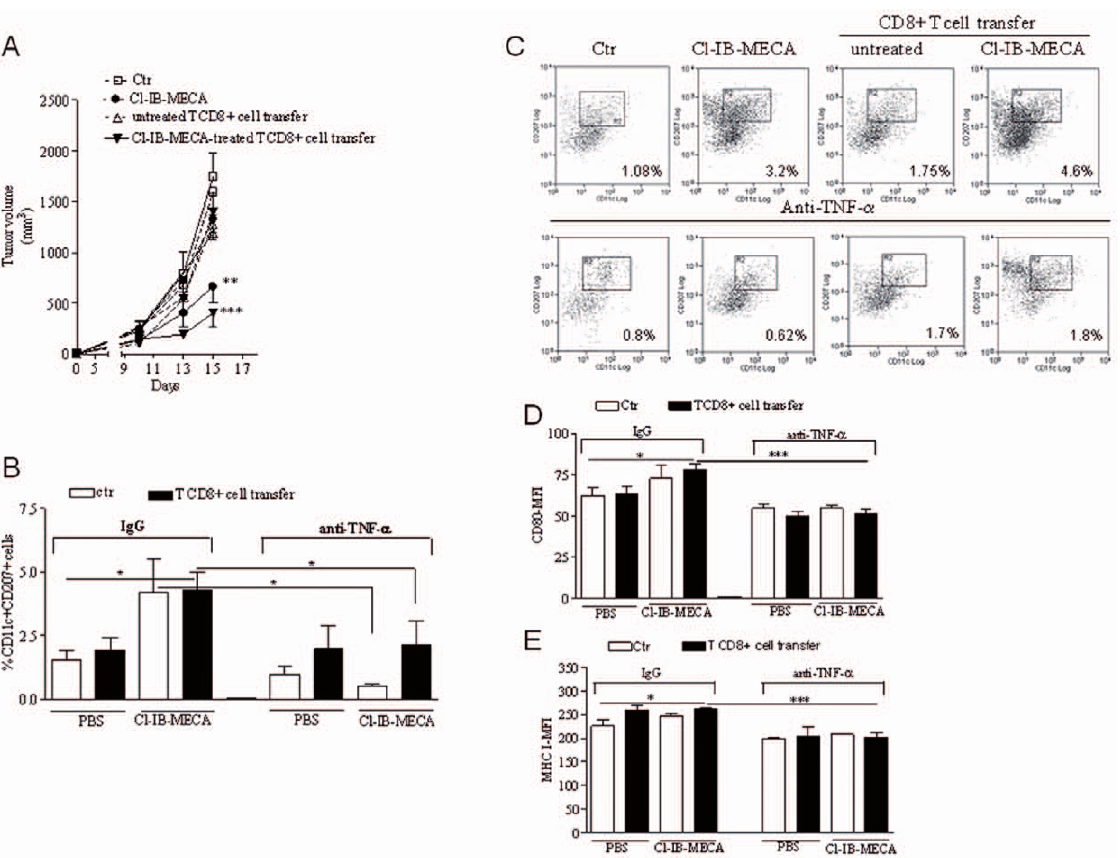
Figure 5. Neutralization of TNF- a abrogated the anti-tumor effect of Cl-IB-MECA-treated CD8 + T cells. A ) Tumor volume (mm3) in mice receiving anti-TNF- a mAb (dashed lines) or isotype IgG control (continuous lines) and injected with Cl-IB-MECA or PBS or CD8 + T cells treated or not with Cl-IB-MECA. B ) Percentage of CD11c + CD207 high cells in the tissue of mice described above. C ) Representative dot plot is shown. D ) and E ) Expression of CD80 and MHC I, respectively, on CD11c + CD207 high cells in the tissue of mice described above. Data are from two independent experiments and represent mean 6 SEM, n=9 for each experiment. Statistical difference was determined by one way ANOVA. *p , 0.05, **p , 0.01, ***p , 0.001. Figure S1 CD8 + T cell enrichment from naı ¨ve spleen. CD8 + T cells were negatively selected from spleen of naı¨ve C57Bl6j mice. Purity of CD8 + T cells was checked by flow cytometry analysis after staining with a PE-conjugated anti-CD8 antibody and was routinely around 90%. Cells were gated as CD3 + CD8 + cells. (TIF)